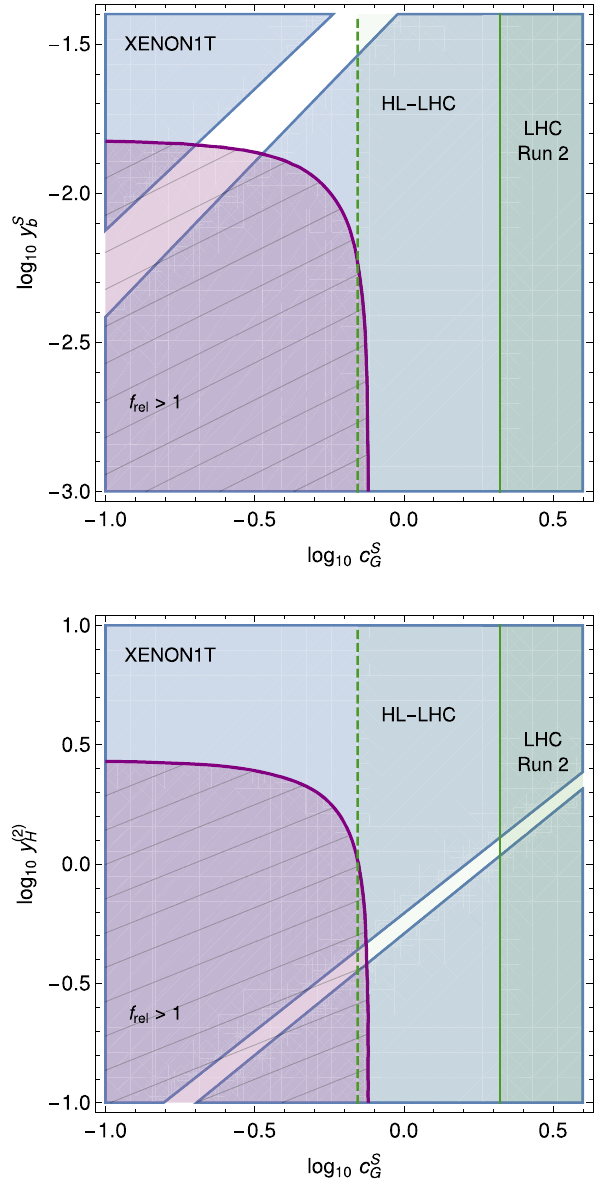
Fig. 6 The solid purple curve shows the relic abundance f rel = 1, while the purple shaded region is excluded by overabundance. The blue shaded region shows the direct-detection exclusion by XENON1T. The darker (lighter) green region depicts the monojet 2 σ exclusion at LHC (projected 2 σ sensitivity at HL-LHC). We have fixed the masses to m χ = 65 GeV and m S = 140 GeV, while the cutoff is set to (cid:7) = 1 TeV and y S = 1